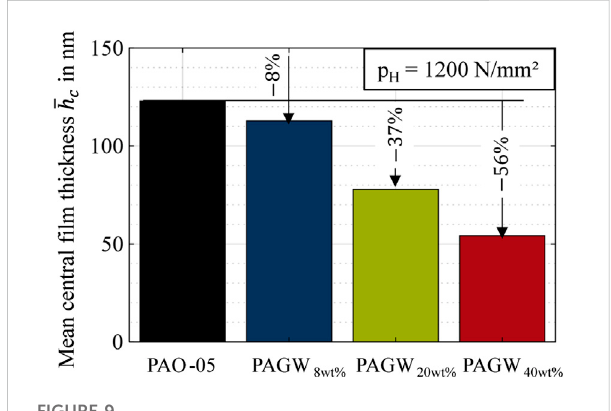
FIGURE 9 Mean central fi lm thickness h c in comparison of the investigated